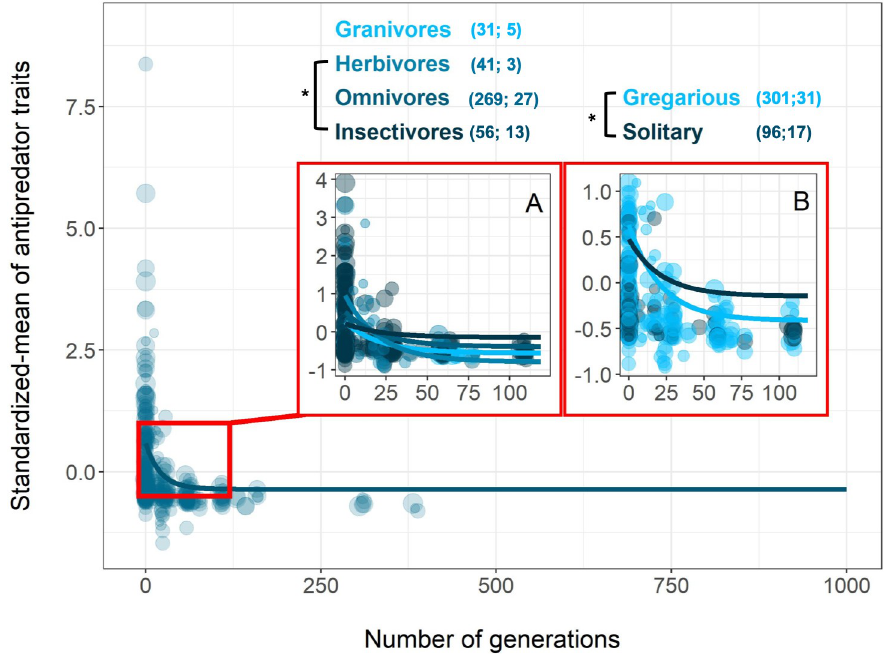
Fig 4. The decrease in average antipredator traits over generations of urbanization differs according to an animal’s foraging type (A) and its social status (B). The lines represent to the best inverse model with the outputs (slopes and intercepts) of the MCMCglmm. In (A), model was fitted with foraging type × generation interaction. In (B), model was fitted with social status × generation interaction. Dot size is proportional to the log-transformed number of replicates used in each study. The number in brackets represents the number of estimates followed by the number of species. “ � ” indicates significant p -value < 0.05 between slopes within each life-history trait using the MCMCglmm model (S3 Table). All data and R code supporting the figure are available in S1C Data. MCMCglmm, Markov chain Monte Carlo generalized linear mixed